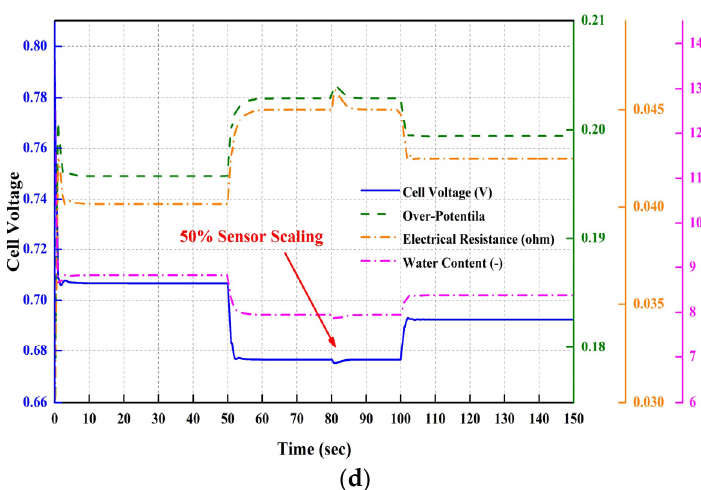
Figure 8. Transient sensor fault behavior in PEM fuel cell under sudden coolant inlet sensor scaling (( a ) Temperature of stack and coolant inlet, ( b ) cooling components, ( c ) heat rejection in stack, ( d ) voltage responses).